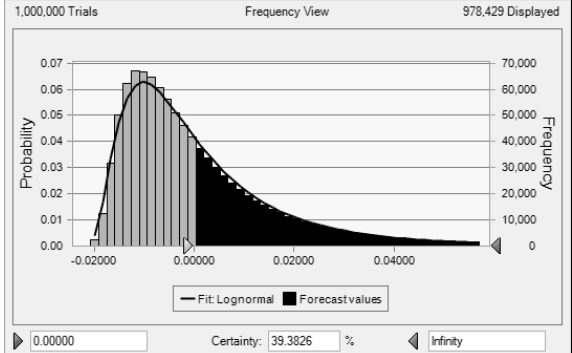
Figure 7 . Simulated distribution of R for the Metro Line 4 Beijing Case. Source: Own calculation applying Crystal